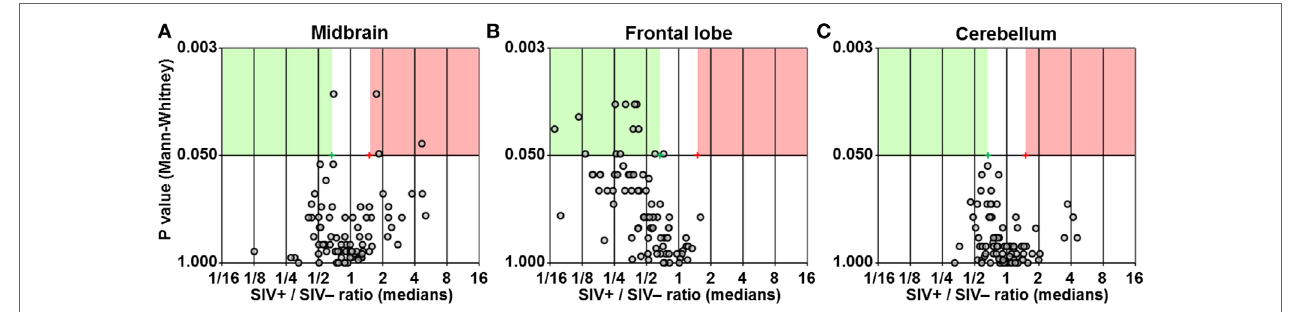
FigUre 2 | Differential expression of inflammatory genes . Volcano plots showing the ratio between median gene expression in simian immunodeficiency virus (SIV)-infected macaques and -uninfected macaques ( x axis; Log 2 scale), in relation to the P value (Mann–Whitney test; y axis; Log 20 scale), for midbrain (a) , frontal lobe (B) , and cerebellum (c) ; each dot represents one gene. Red and green areas highlight genes upregulated or downregulated in SIV-infected compared to -uninfected animals (1.5-fold; P <